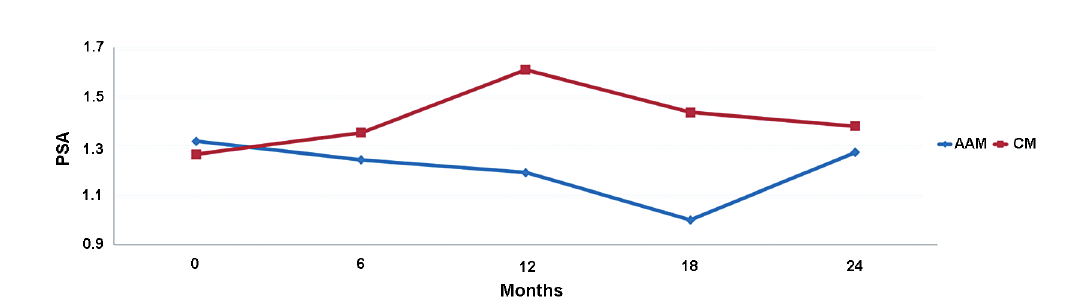
Figure 1 – Comparing prostate-specific antigen (PSA) change of African American men (AAM) versus Caucasian men (CM) treated with testosterone replacement therapy in 6-month